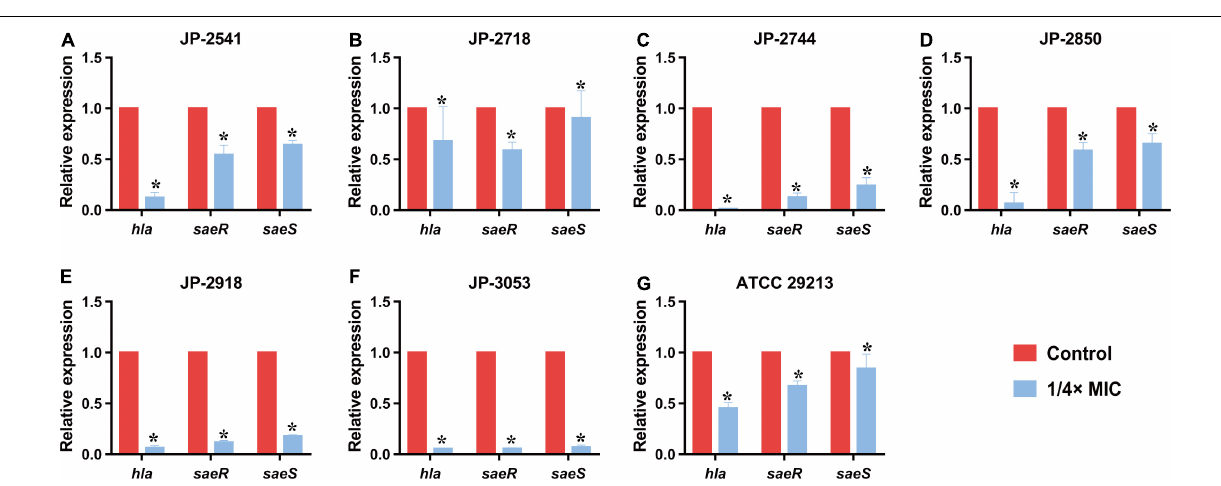
FIGURE 6 | Relative expression level of hla , saeR , and saeS in S. aureus strains after culturing with 1/4 × MIC concentration of CDB. * P < 0.05. (A) Genes expression level in JP-2541. (B) Genes expression level in JP-2718. (C) Genes expression level in JP-2744. (D) Genes expression level in JP-2850. (E) Genes expression level in JP-2918. (F) Genes expression level in JP-3053. (G) Genes expression level in S. aureus ATCC